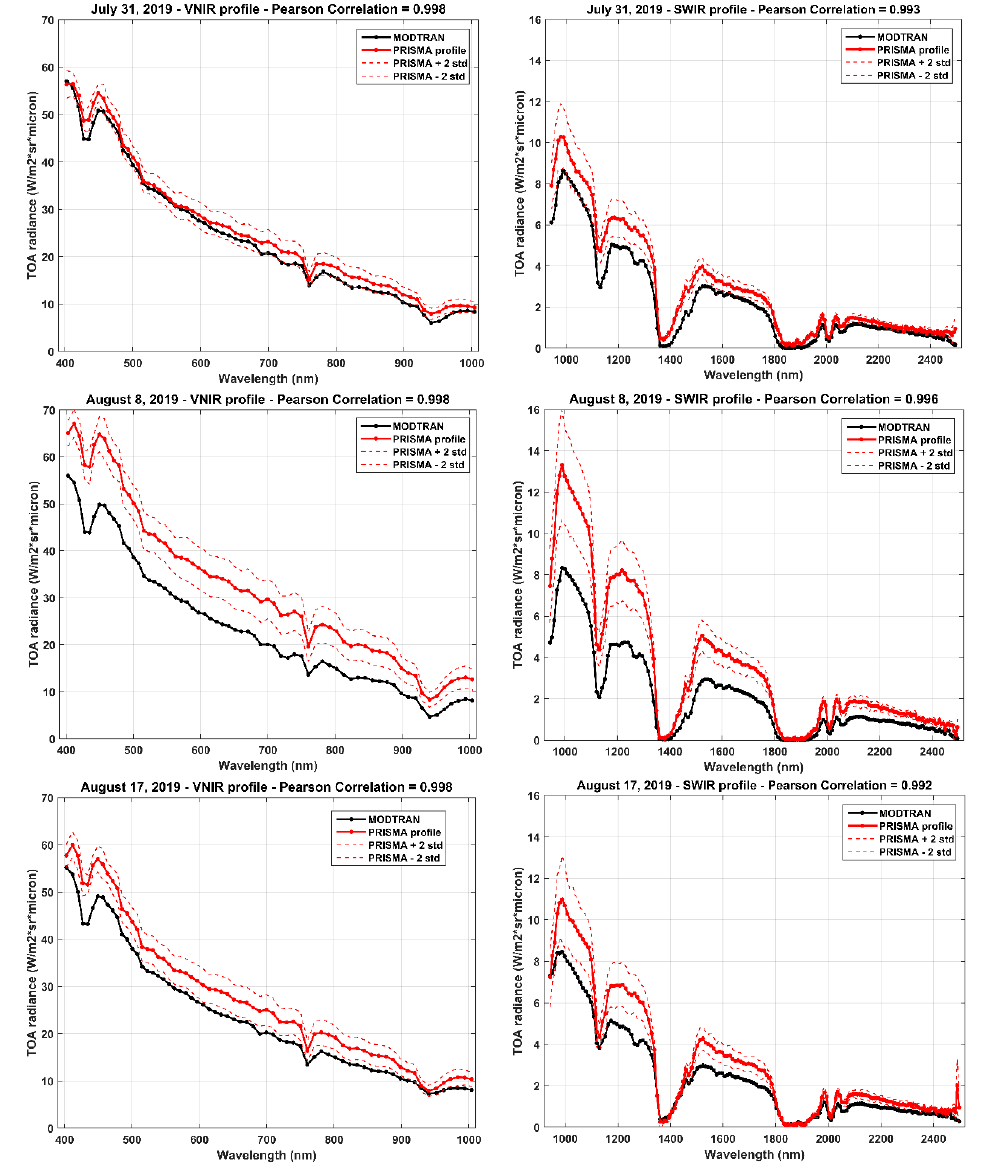
Figure 5. Spectral profiles of PRISMA (red line) and MODTRAN simulations (black line) for VNIR (on left ) and SWIR (on right ); acquisitions and simulations on 31 July, 8 and 17 August 2019.